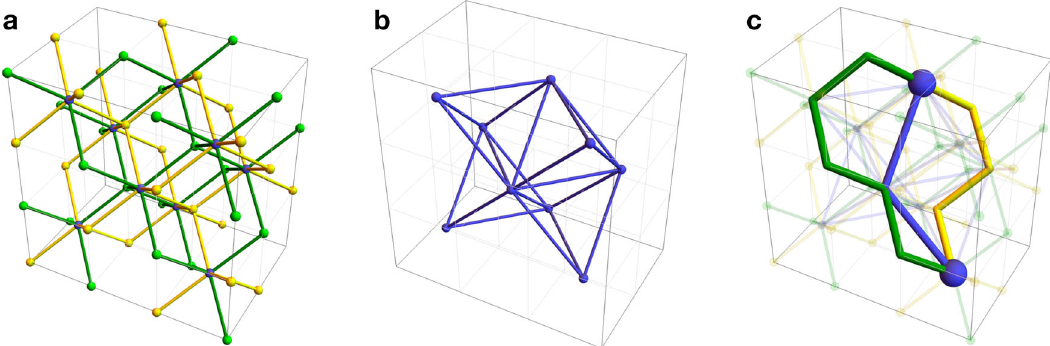
fl ux φ (green and yellow edges), which may arise for a Pauli X error ϵ and its stabilizer syndrome ∂ S ϵ (blue edges and balls). Note that φ satis fi es the Gauss law and is not uniquely speci fi ed by ϵ